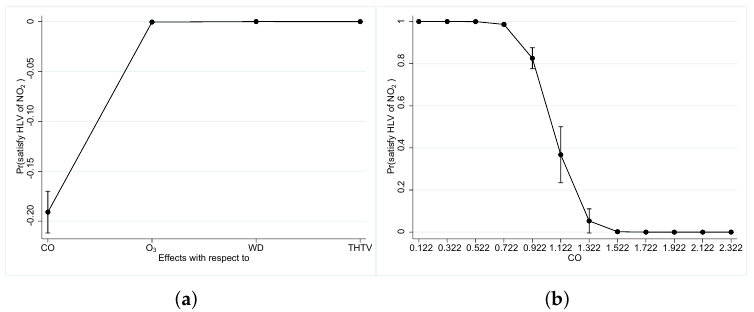
Figure 10. Average marginal effects without segmentation. ( a ) Impact of all significant inputs. ( b ) Impact for all admissible values of CO.